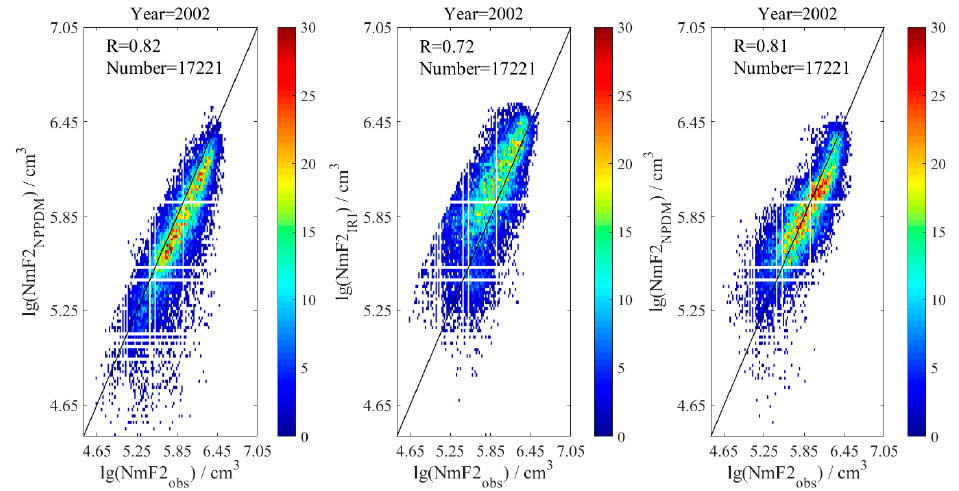
Figure 4. Data density of NPPDM (left), IRI2016 (middle), and NPDM (right) versus IRO NmF2 in 2005.